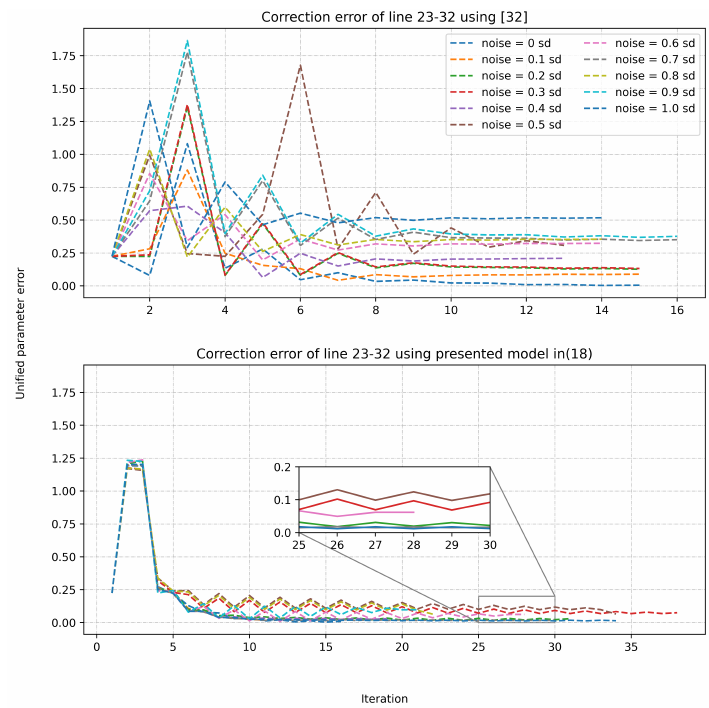
Figure 4. Correction for line 47–69 using presented model